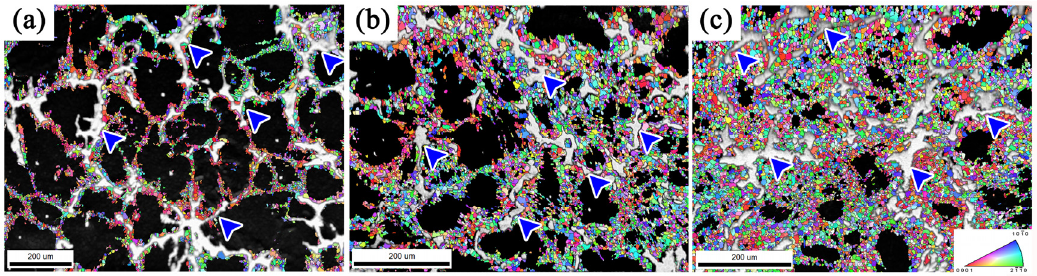
Figure 10. The regions with block-shaped phase and DRXed grains: ( a ) 1 pass; ( b ) 2 passes; ( c ) 3 passes.